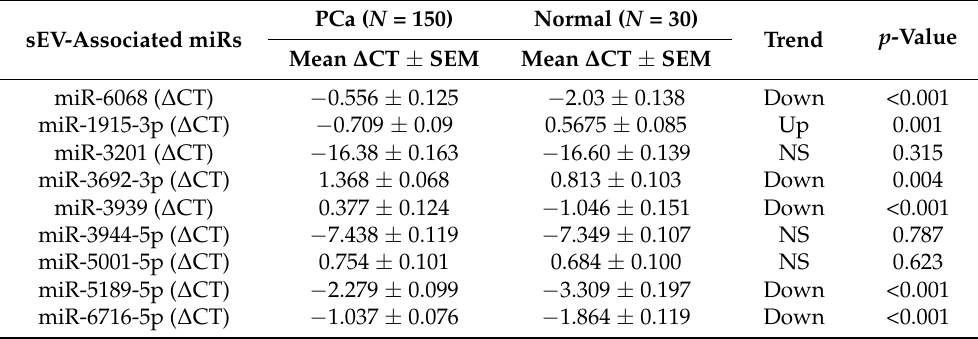
Table 2. Differential expression of sEV-associated miRs in PCa patients compared to normal individ- uals in confirmatory cohorts.